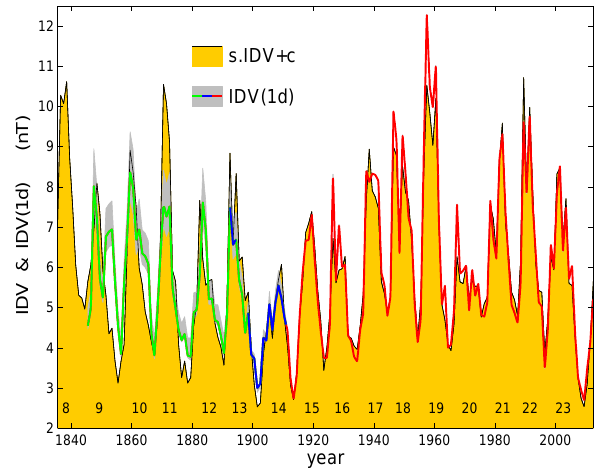
Fig. 13. Annual means of the IDV(1d) composite, with data origi- nating from ESK in red, NGK in blue and HLS in green. The black line bounding the filled orange area is the IDV index of SC10, scaled using the regression for 1880–2013, as shown in Fig. 9. The grey area shown is the band of uncertainty that arises from the two re- gression fits used to compile the composite (so between 1890 and 1911 the uncertainty arises from the NGK–ESK regression and be- fore 1890 it arises from both the NGK–ESK and the HLS–NGK regressions). Solar cycle numbers are given across the base of the